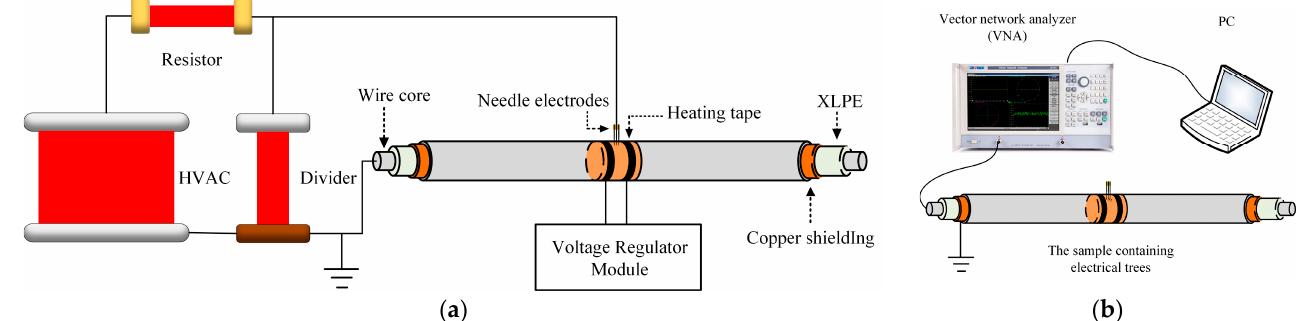
Figure 2. BIS test system of cables containing electrical trees: ( a ) AC electrical tree test circuit diagram; ( b ) BIS circuit diagram.